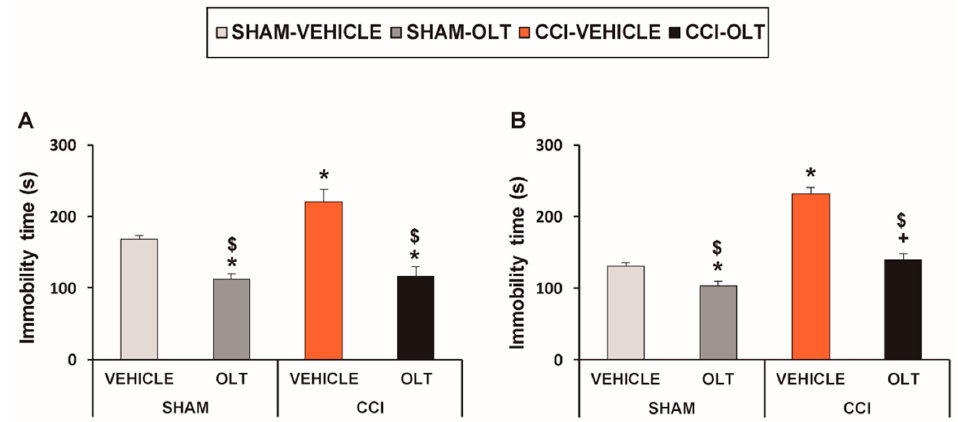
Figure 2. Repeated treatment with oltipraz reduces depressive-like behaviors in CCI-injured mice. Immobility time (s) evaluated by the ( A ) tail suspension test (TST) and ( B ) forced swimming test (FST) 28 days after surgery in the CCI-injured and sham-operated (SHAM) mice treated for 11 consecutive days with 10 mg/kg of oltipraz (OLT) or vehicle is shown. For each test evaluated, * denotes significant differences vs. sham-operated mice treated with vehicle, + denotes significant differences vs. sham- operated mice treated with oltipraz, and $ denotes significant differences vs. CCI-injured mice treated with vehicle ( p < 0.05; one-way ANOVA followed by the SNK test). Results are presented as the mean ± SEM; n = 8 animals per experimental group.